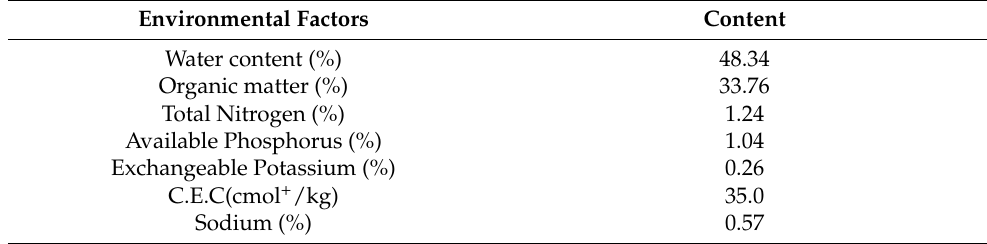
Table A1. Chemical properties of organic fertilizer chosen as a soil ameliorator in this